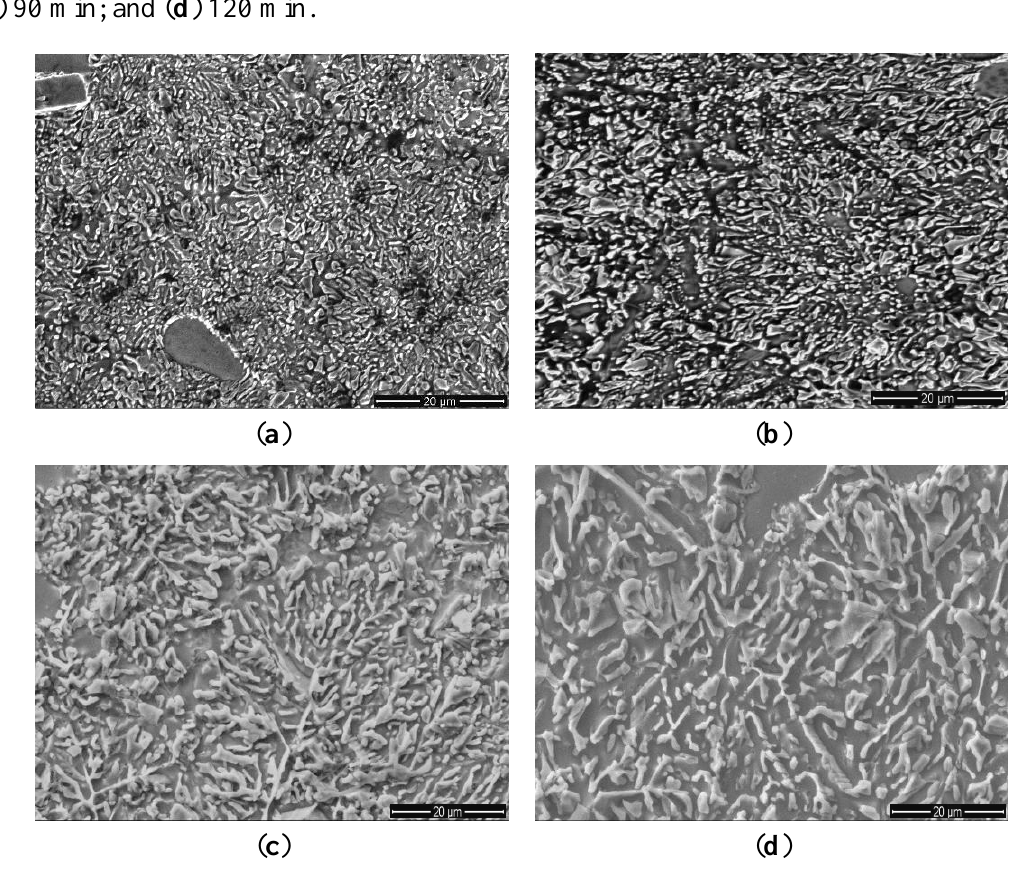
Figure 7. SEM images of eutectic Si crystals in hypereutectic Al–20%Si alloy with 0.6 wt% Al–5Ti–C master alloy at different heat treatment times: ( a ) 30 min; ( b ) 60 min; ( c ) 90 min; and ( d ) 120 min.